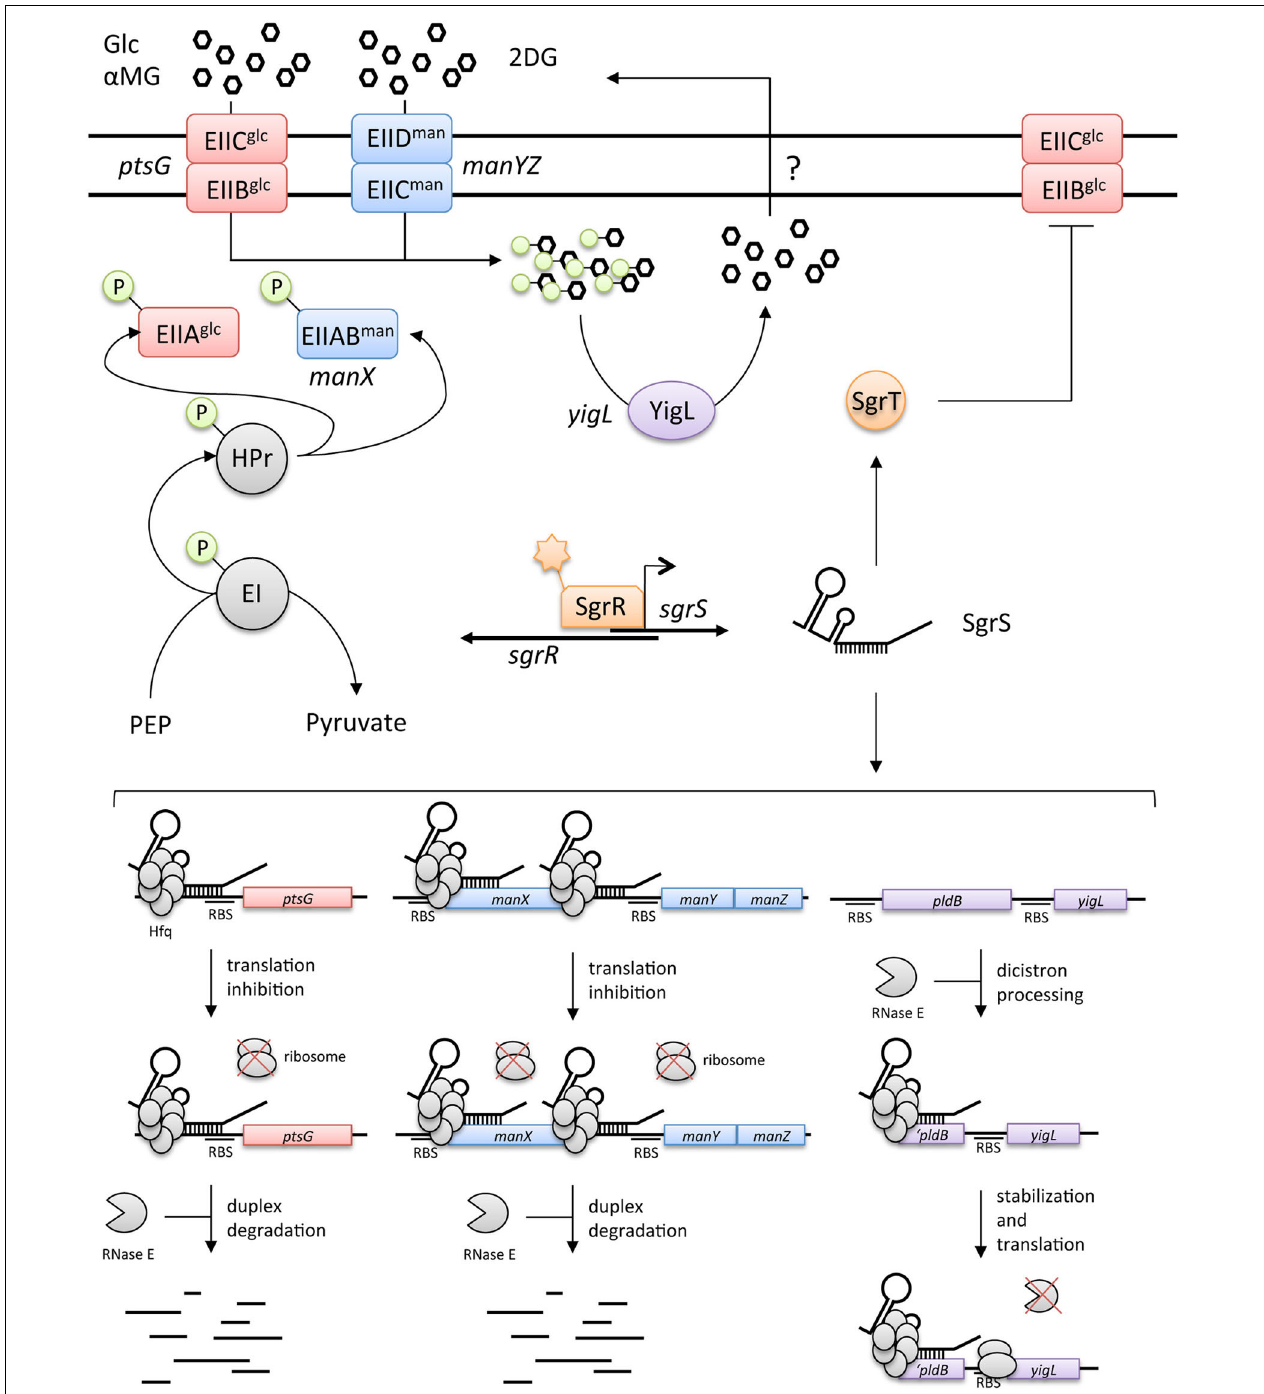
FIGURE 1 | Current model for the role of SgrS in the glucose-phosphate stress response. The top panel illustrates the main features of the phosphoenolpyruvate phosphotransferase system (PTS), which transports numerous carbohydrates as well as glucose analogs ( α MG, 2DG: α -methyl glucoside and 2-deoxy glucose, respectively). Glucose-phosphate stress is associated with accumulation of sugar-phosphates (hexagons with attached green circles). The stress response is initiated by the activated transcription factor, SgrR, which induces SgrS synthesis. SgrS has two functions; the first is base pairing-dependent regulation of target mRNAs (illustrated in lower